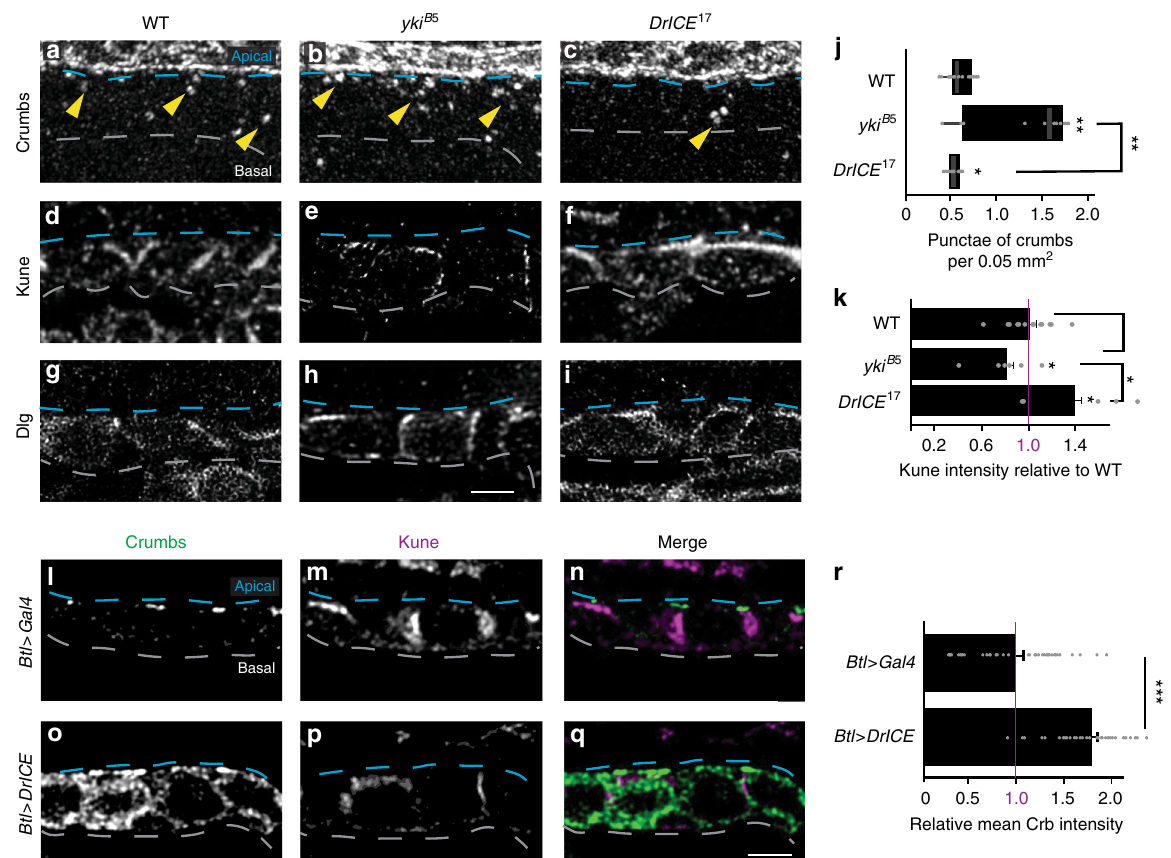
Fig. 3 DrICE regulates abundance and localization of the size determinants Crb and Kune. a – c Number of Crb cytosolic punctae (yellow arrowheads) is increased in yki B5 mutants ( b ) but decreased in DrICE 17 mutants ( c ) compared to WT ( w 1118 ) ( a ) at stage 14. d – f Cytoplasmic Kune abundance is decreased in yki B5 and increased in DrICE 17 relative to w 1118 . Quanti fi cation in k . g – i Levels of the basolateral septate junction protein Dlg appear minimally affected in yki B5 and DrICE 17 mutants, indicating that the ability of DrICE to regulate traf fi cking is selective. j The number of cytoplasmic punctae of Crumbs at embryonic stage 14 is reduced in DrICE 17 tracheal cells compared to w 1118 and increased in yki B5 relative to w 1118 . Punctae were counted in two ROIs in each of two z- slices for N ≥ 5 embryos and normalized to ROI area. Center line represents the median, box limits are the upper and lower quartiles, whiskers are 1.5× interquartile range. k Mean intensity of Kune in a maximum projection of the fi fth tracheal metamere was measured in N ≥ 5 embryos of each genotype then normalized to the WT ( w 1118 ) control. l – q Overexpression of DrICE in the trachea increases Crb levels relative to the control at stage 16 ( l vs. o ), consistent with the decrease of Crb punctae in stage 14 DrICE 17 mutants. Quanti fi ed in r . Conversely, Kune levels are decreased when DrICE is overexpressed ( m vs. p ). r Cytoplasmic Crb abundance is dramatically increased in btl>DrICE relative to btl>Gal4/ + . Mean Kune intensity was measured in two ROIs in each of fi ve z- slices for N = 4 embryos of each genotype and quanti fi ed relative to the btl > Gal4 / + control. For all graphs, error bars represent S.E.M. and each data point is represented as a point. Source data are provided as a source data fi le. Blues dashed lines mark the apical cell surface, white dashed lines mark the basal cell surface. Scale bar for a – i in i , 2.5 μ m; for l – m in m , 2.5 μ m. * p < 0.05; ** p < 0.005; *** p < 0.0005 Student ’ s t